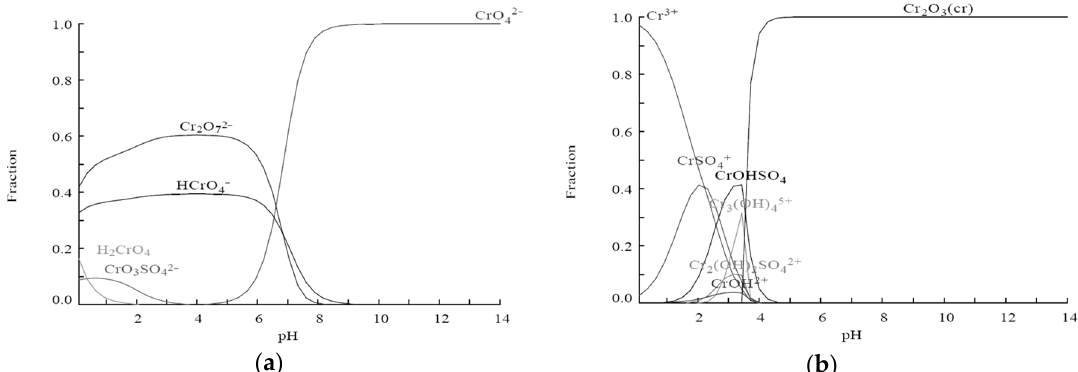
Figure 1. Speciation diagrams of ( a ) Cr (VI) and ( b ) Cr(III). [Cr] = 0.05 mol·L − 1 , ionic strength = 0.1 mol·L − 1 , T = 25 °C. Calculation performed with Medusa by using the thermodynamic data reported in Table 2. Table 2. Thermodynamic constants (25 °C) for the calculation of the speciation diagram of Cr (VI) [14]. Equilibria Thermodynamic Constants at 25 °C